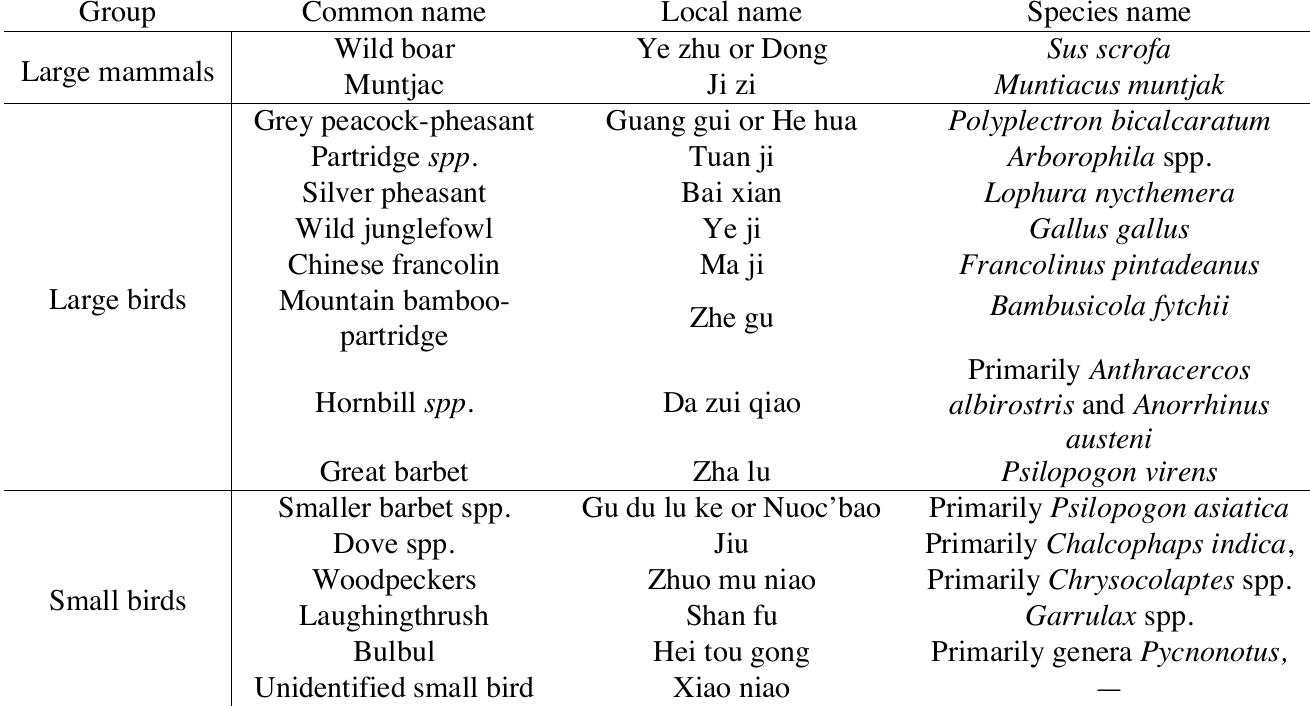
Table A2 : The list of species provided on the hunting trip data sheets. Common name denotes the species or genus of